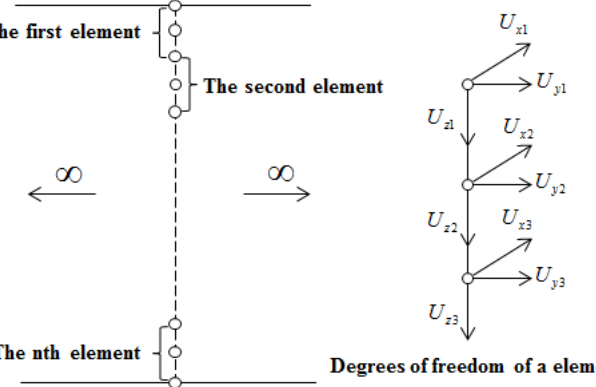
Figure 2. Discretization of a plate with one-dimensional three-node elements.